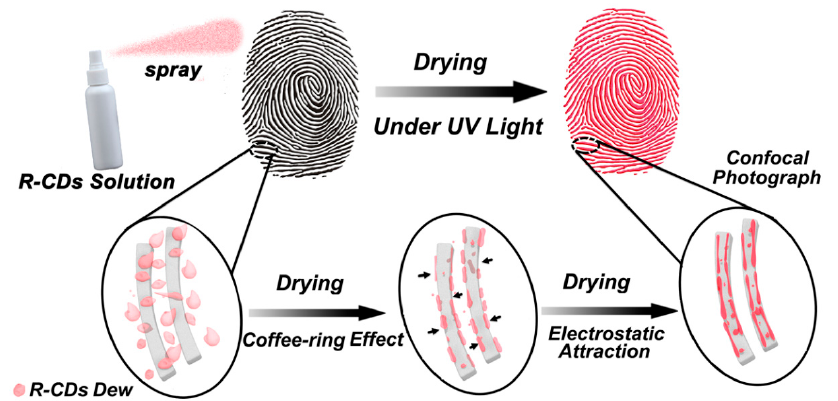
Figure 5. The fingerprint staining process and the mechanism by which the C-dots adhere to the fingerprints. Reprinted with permission from reference [47]. Copyright (2017) American Chemical Society.